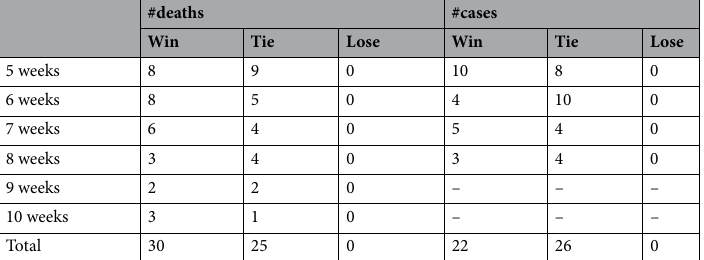
Table 1. T-test results. The null hypothesis was that the MAPEs of LaFoPaFo and the CDC models follow the same distribution. The test was performed for each of the future 5, 6, …, 10 future weeks forecasts, comparing LaFoPaFo to each of the CDC models. “Win” means that the average MAPE of LaFoPaFo is lower than the CDC model and that the difference is statistically significant. “Tie” means that the difference in MAPE is not statistically significant. “Lose” means that the MAPE of the CDC model is lower and that the difference is statistically significant. LaFoPaFo never lost against any of the CDC